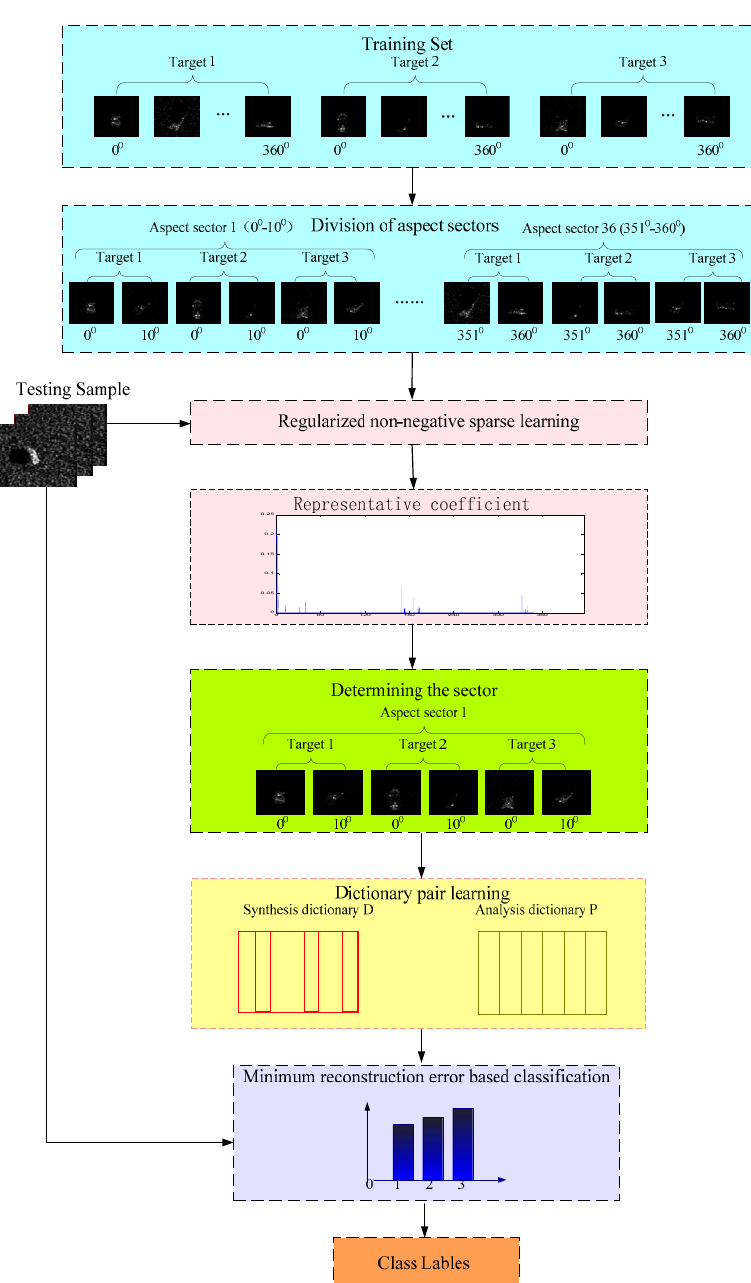
Figure 2. The scheme of adaptive local aspect dictionary pair learning based SAR target images classification.